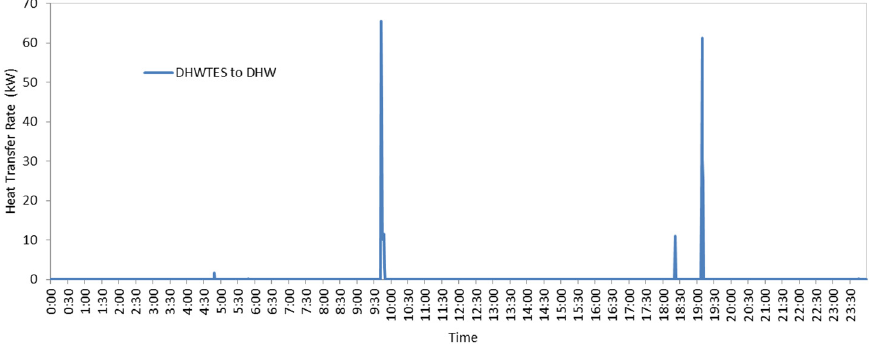
Figure 13. Heat transfer rate from the DHW TES tank to the DHW delivered to the house on 24 of August 2019.